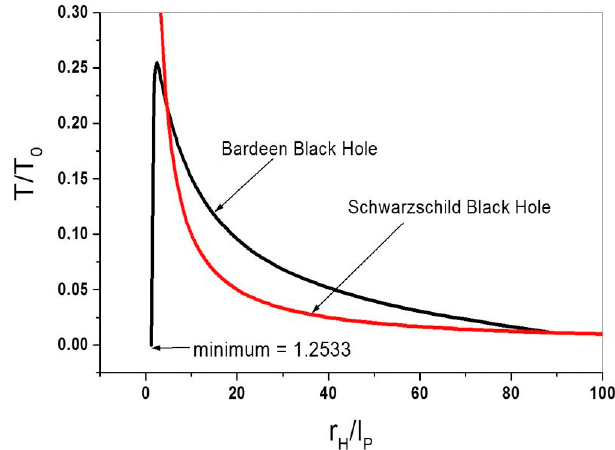
Figure 1. Normalized horizon temperature for Bardeen (black curve) and Schwarzschild (red curve) black holes as a function of the horizon radius in units of the Planck scale distance.